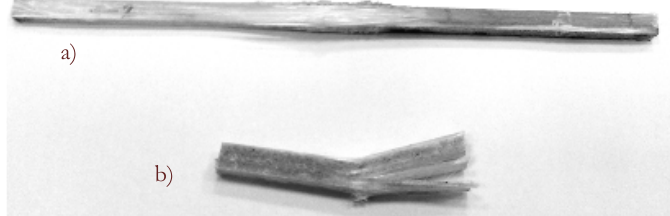
Figure 8: Failed unidirectional fiberglass (Direct "E" roving 0.7 - orthophthalic polyester resin 0.3) at three point bending tests on large (a) and small (b)